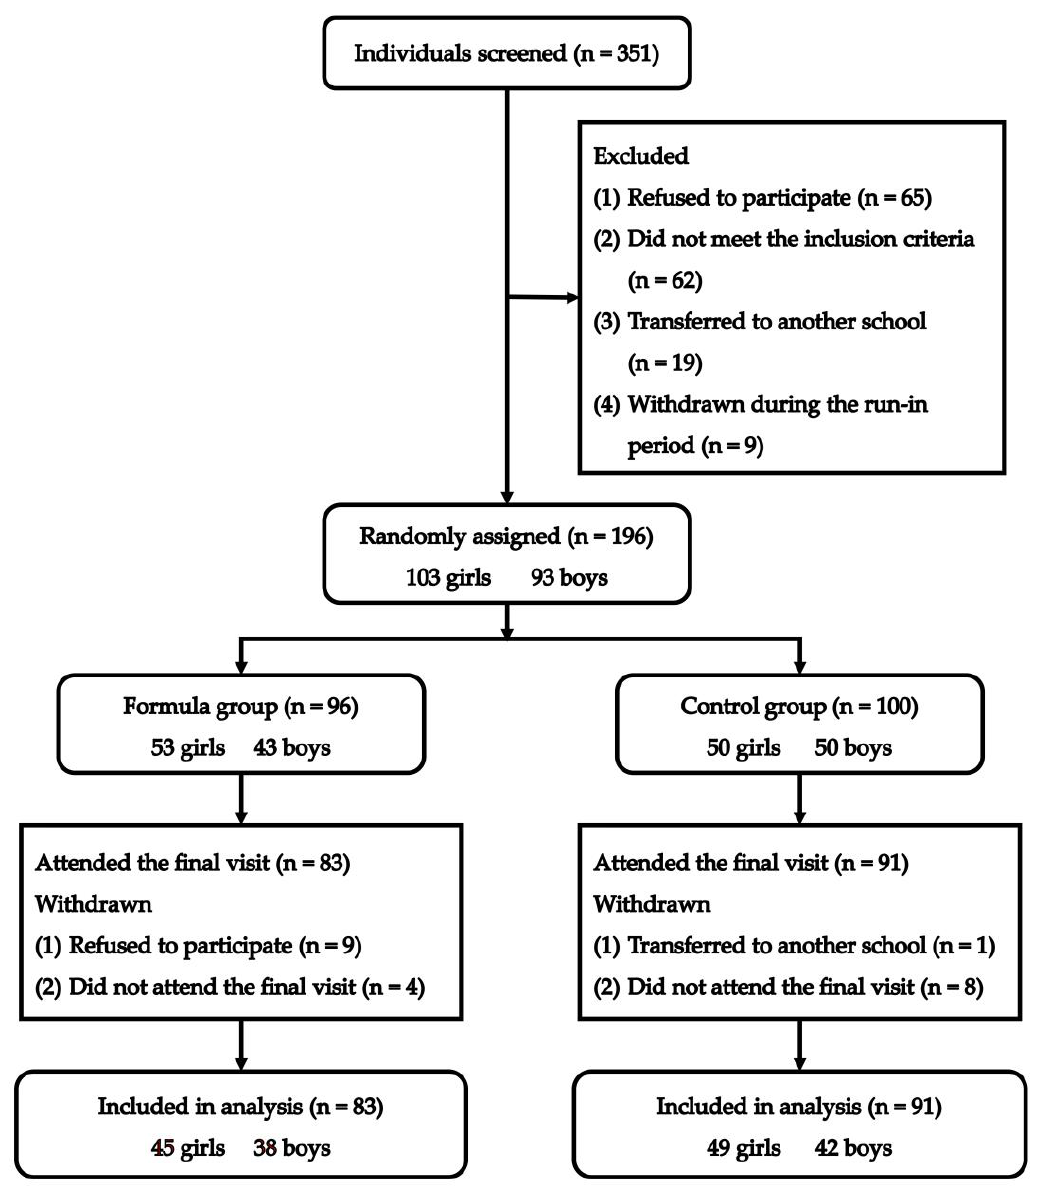
Figure 1. Flow diagram of the recruitment and follow-up of study participants.